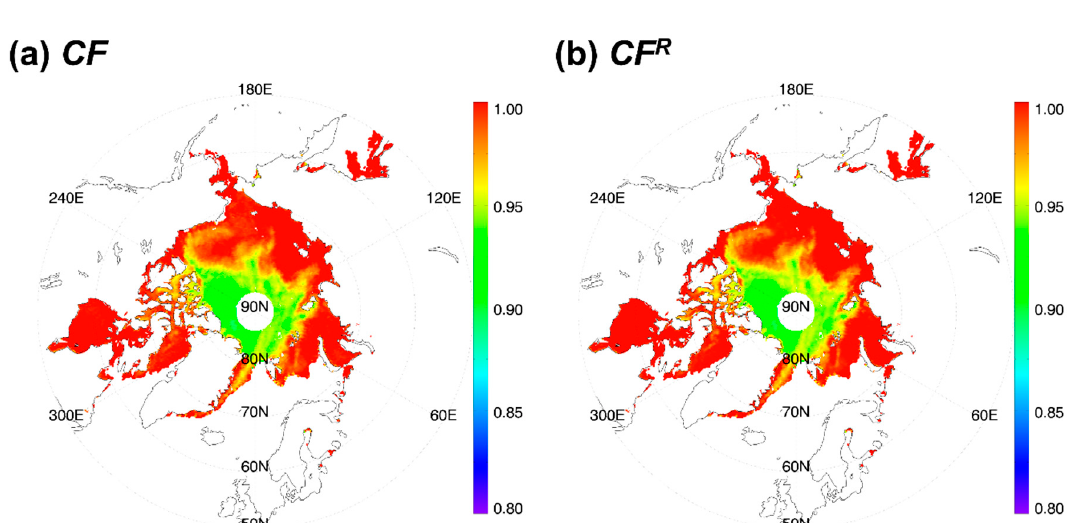
Figure 2. Geographical distributions of ( a ) directly calculated CF and ( b ) regression-based CF R at 19.4 GHz (explained in detail in Section 3.4) on 1 January 2004.